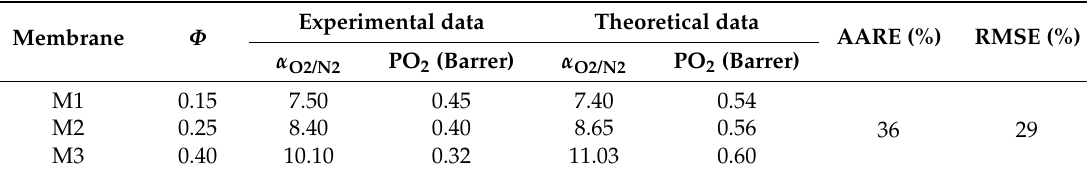
Table 3. Experimental [41] and theoretical MOT-predicted data for the zeolite 4A-poly (vinyl acetate) mixed-matrix membranes.